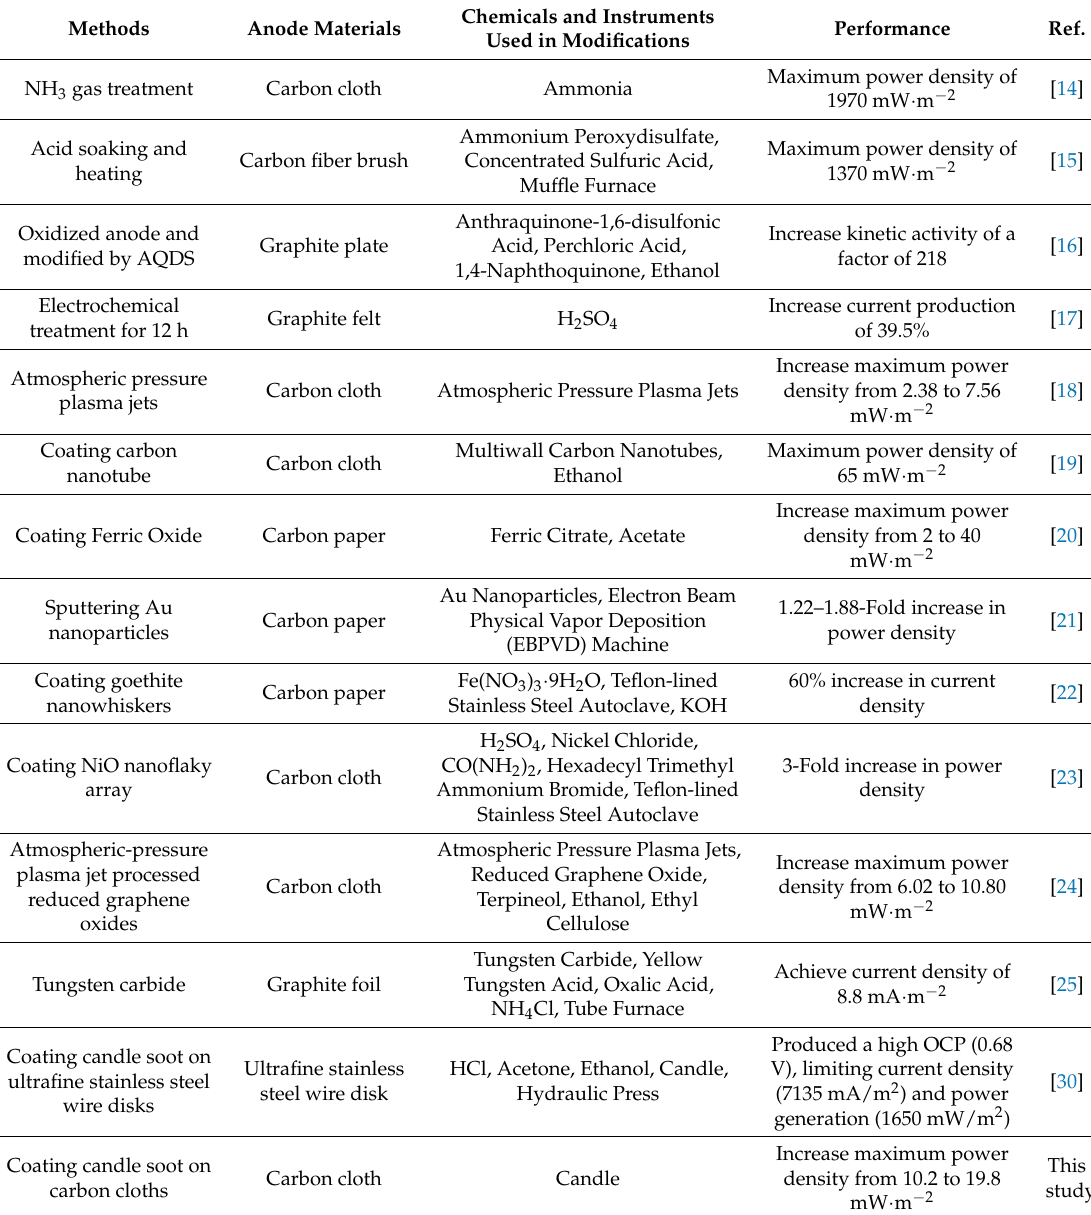
Table 2. Comparison of the chemicals and instruments used in various anode